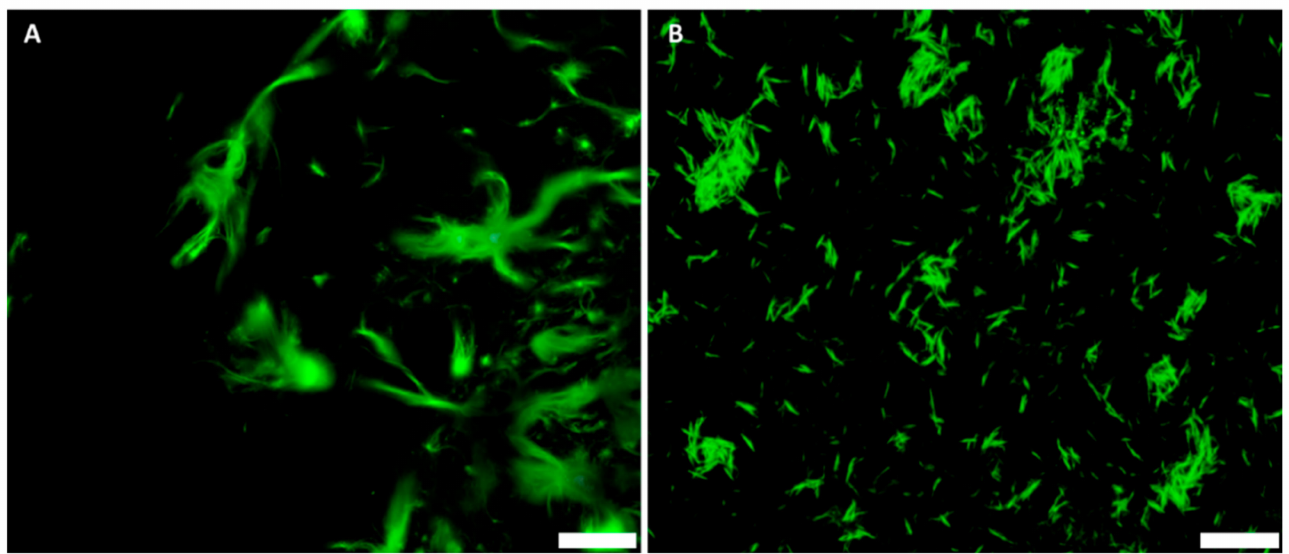
Figure 4. FM images of GFP–CBM (0.05 mg/mL) bound onto ( A ) BNC and ( B ) BCNC after 2 h of incubation. BNC and BCNC stock solutions were both at 0.25 mg/mL. Scale bar: 10 µ